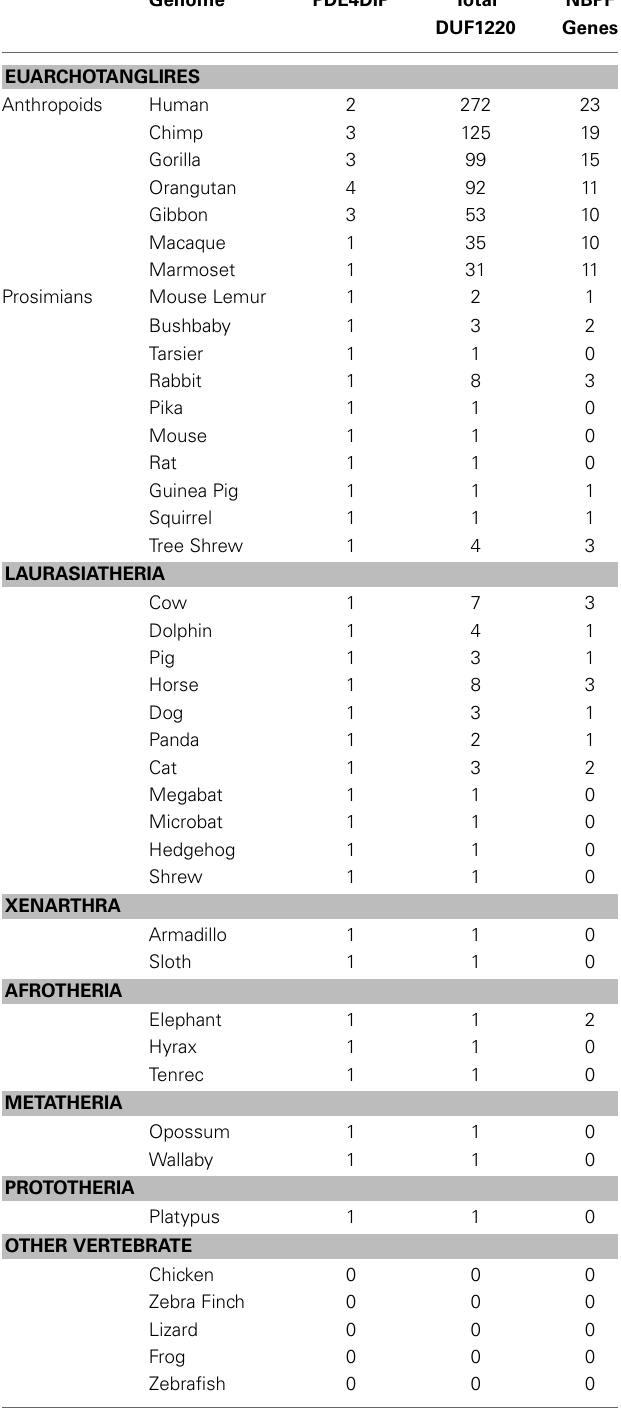
Table 1 | DUF1220 Copy Number in 41 Animal